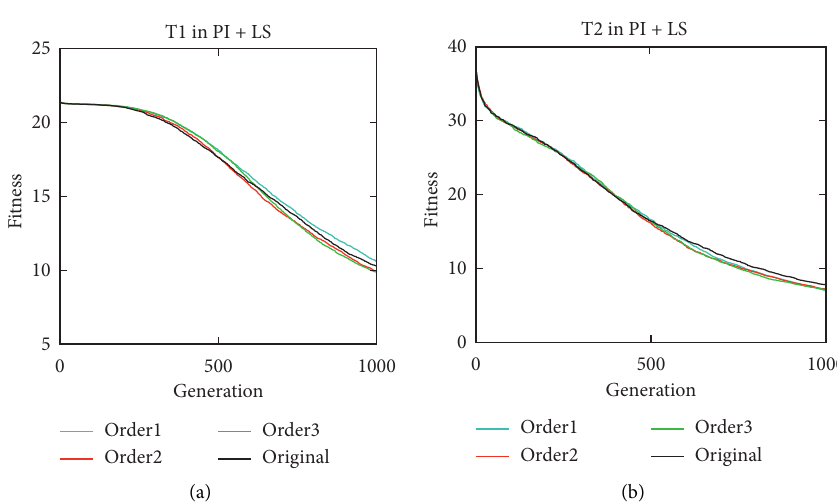
Figure 18: Convergence of MFDE for problem 6 (PI+